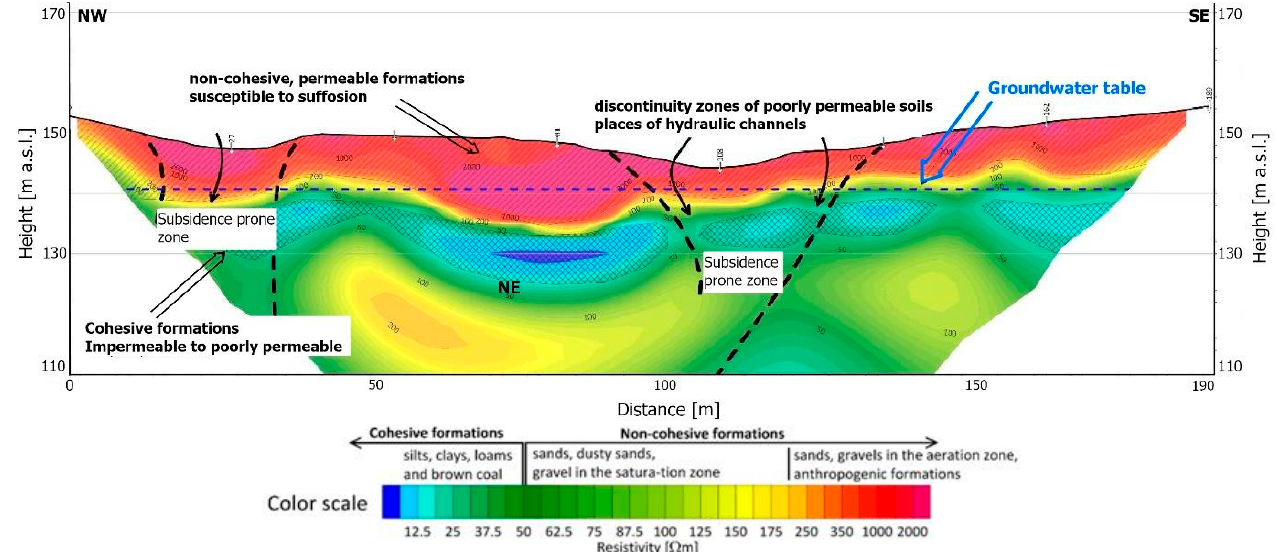
Figure 9. Diagram of interpretation of the hydrogeological conditions along profile (shown in Figure 5) in test-field three.